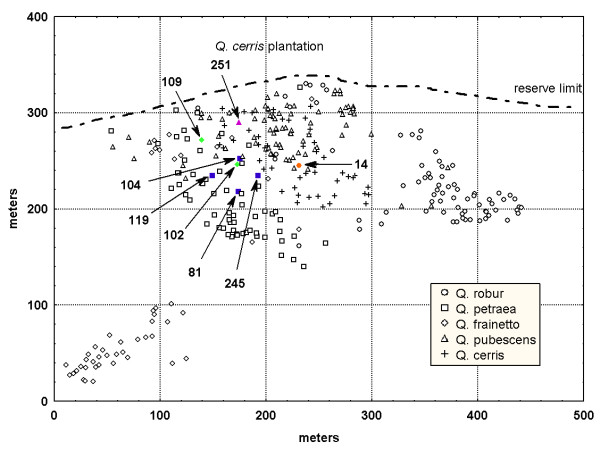
Location of the adult trees in the study area [24]. Each species is shown by a different form. The eight maternal trees are shown by filled forms.